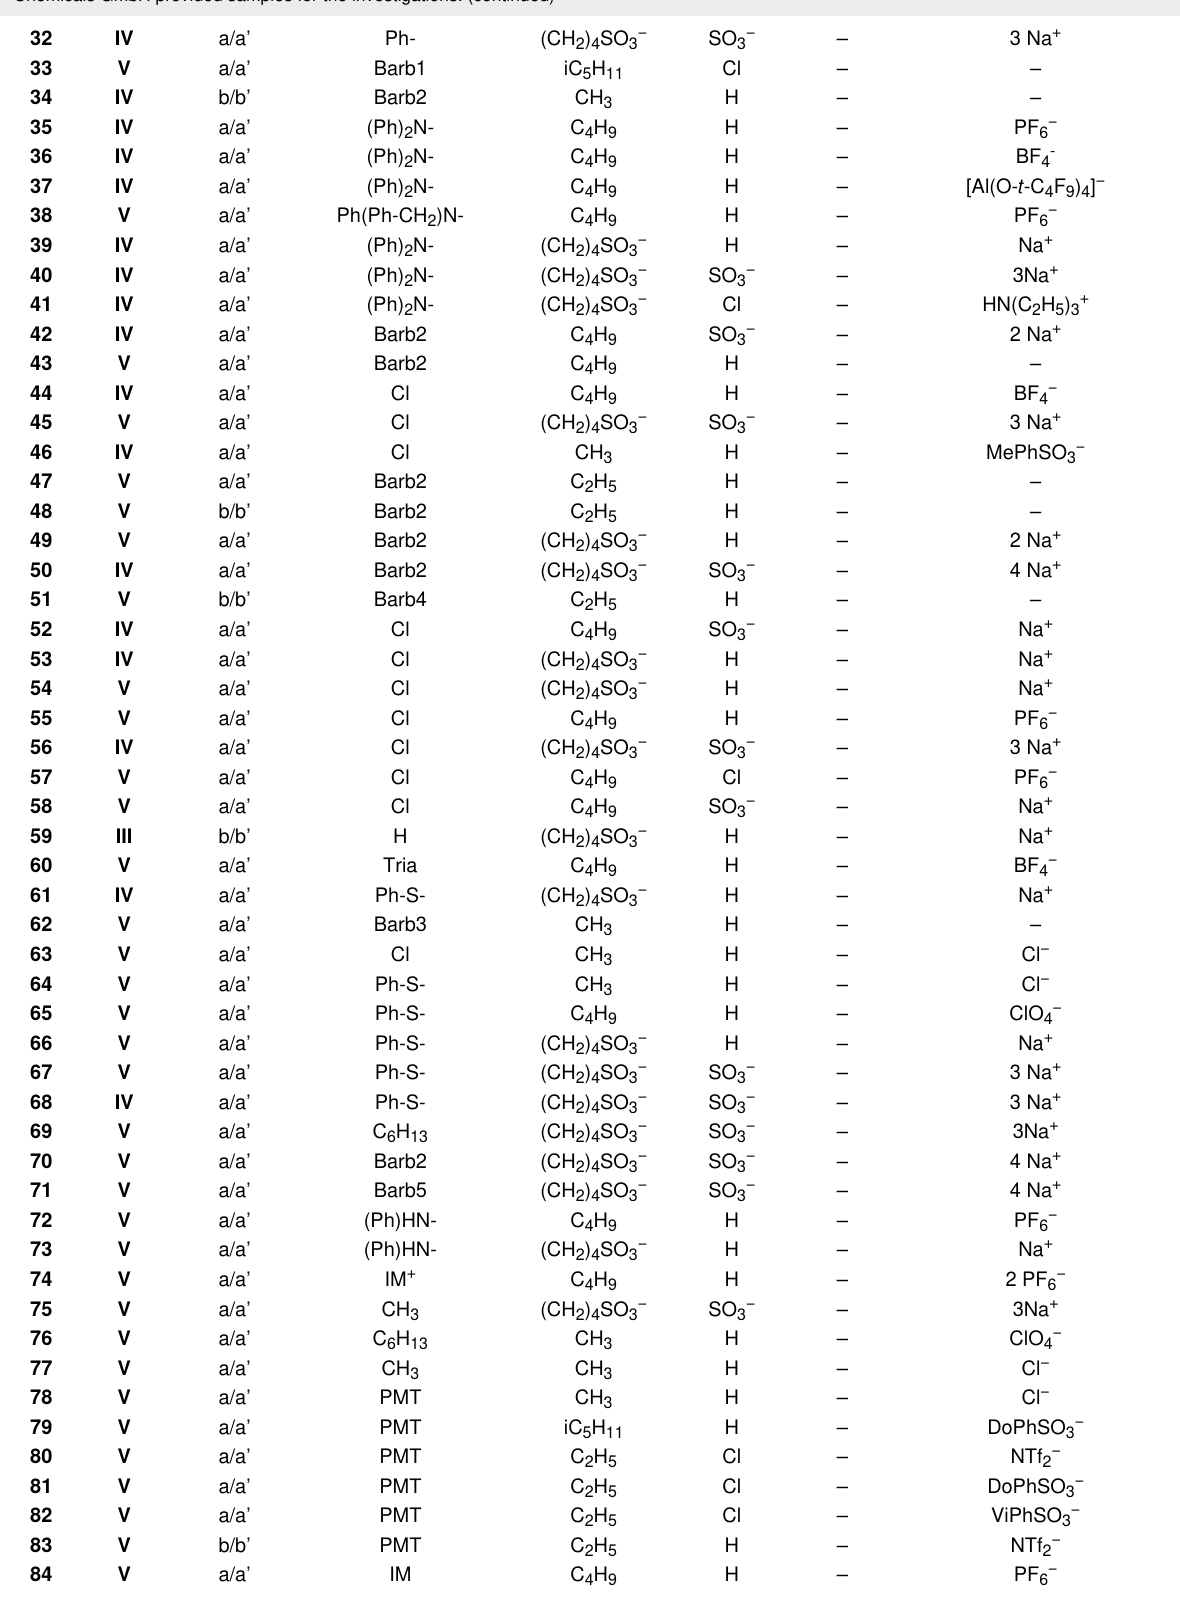
Table 1: Summary of structure elements of absorbers related to the structural patterns I – V . Table 2 summarizes their photophysical data. FEW Chemicals GmbH provided samples for the investigations.